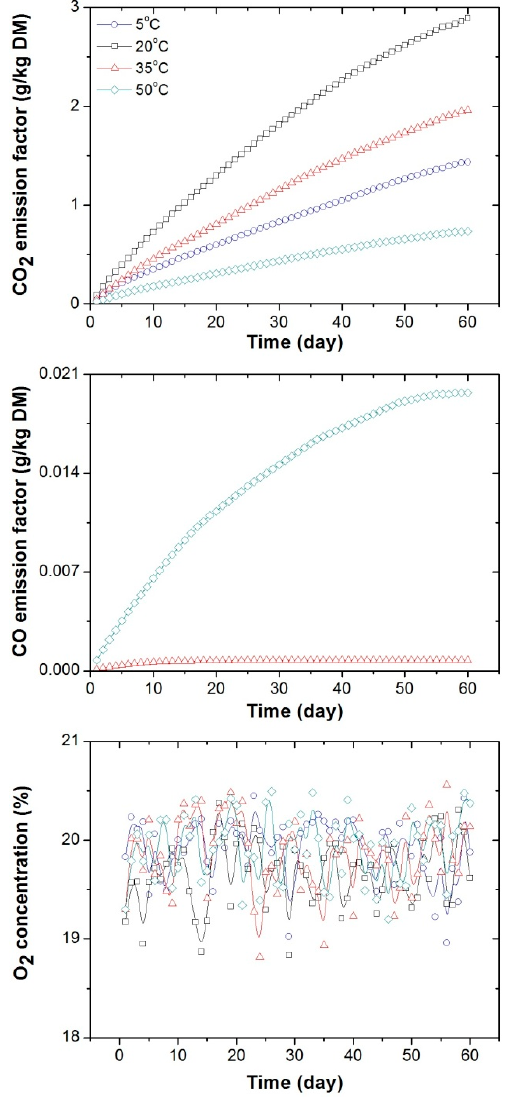
Figure 5. Cumulative gas emissions from WRC chips with initial moisture content of 35% under aerobic